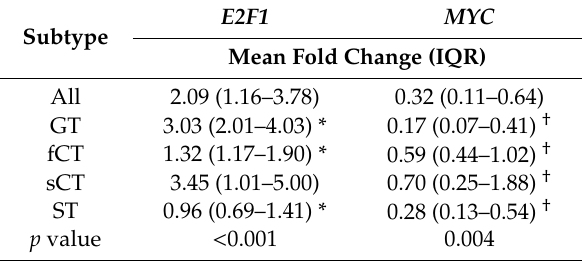
Table 3. Distribution of E2F1 and MYC expressions (fold change) according to PitNET subtype .